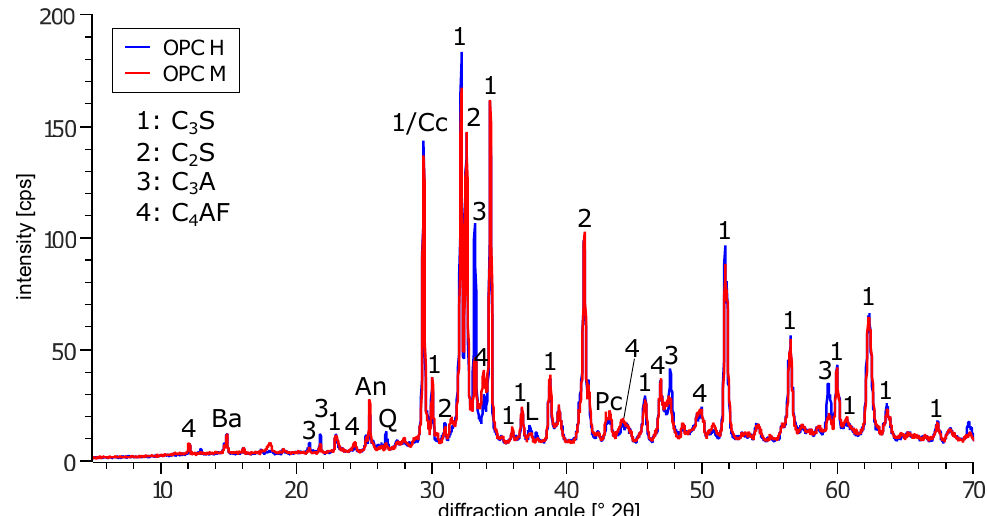
Figure 2. X-ray diffraction patterns of the binders used in this study. An: anhydrite; Ba: bassanite; Cc: calcite; L: lime; Pc: periclase; Q: